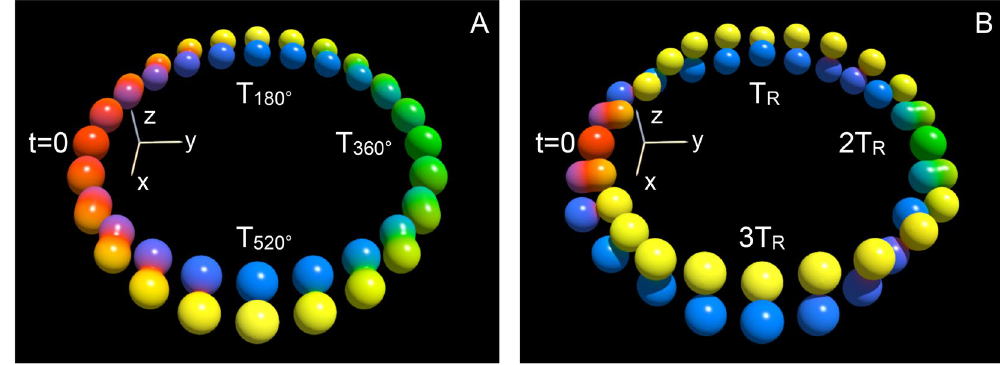
Figure 4. Drops representation of the propagators. Trajectories of the propagators U ( t ) for standard rectangular pulses of constant amplitude and phase ( A ) and by TRE pulses ( B ) as a function of time. In panels (A,B), T 180 and T R are pulse durations corresponding to a 180°-rotation around the x -axis. In the DROPS representation 29 , operators are depicted by complex spherical functions θ φ θ φ = η f f e ( , ) ( , ) i , where for given azimuthal and polar angles θ and φ , the absolute value θ φ f ( , ) is represented by the distance from the origin and the phase angle is color coded ( η = 0 : red, η = π : yellow, η π = : green, η = π 3 : blue). At t = 0, the propagator is the 2 2 identity operator 1 (represented by red spheres), while at ( A ) t = T 360° = 2 T 180° and ( B ) t = 2 T R the propagator is − 1 (represented by green spheres). In panels (A,B), the identity operator is created again at t = 4 T = T 180° 720° and t = 4 T R , respectively.